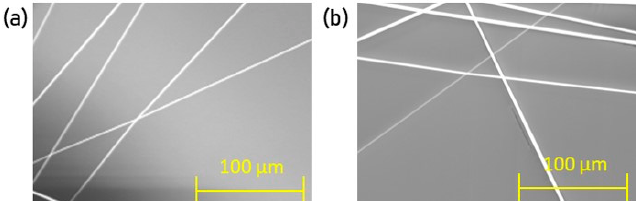
Figure 5. SEM imaging of electrospun fibres showing homogeneous morphology. Electrospun fibres from ( a ) 10% w / v at 70:30 polycaprolactone to gelatine solutions ratio and ( b ) 12% w / v at 50:50 PCL solution:Ge solution polymers shown. Electrospinning parameters: time: 15 s, solvent: TEF, voltage range: 9.82–10.56 kV, distance between nozzle and collector: 15 cm.